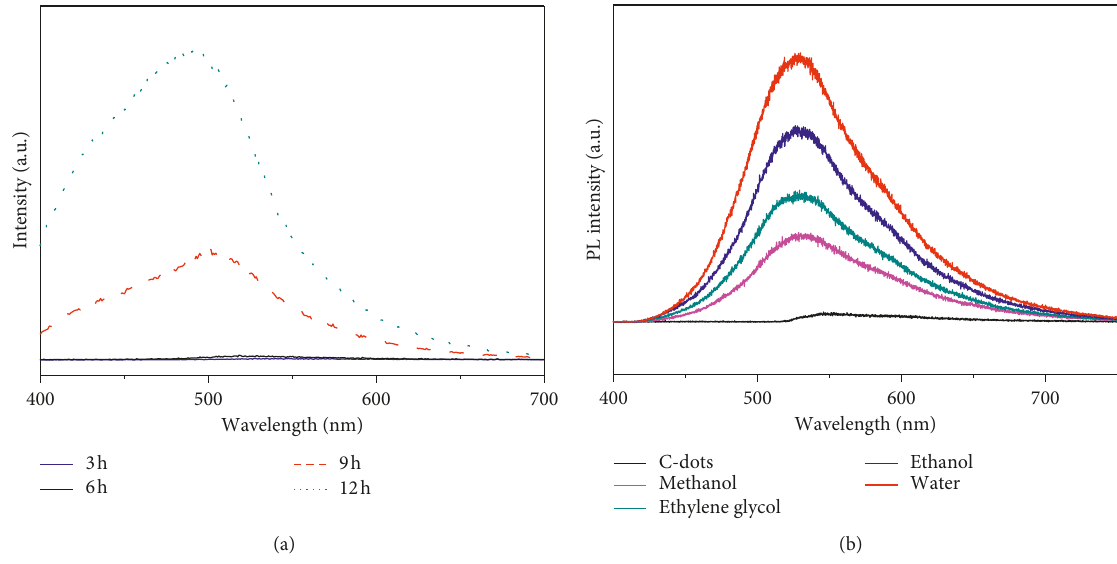
Figure 8: Luminescence spectra of C-dots synthesized at (a) 280 ° C with different hydrothermal time and (b) 200 ° C in 12h in various diluted